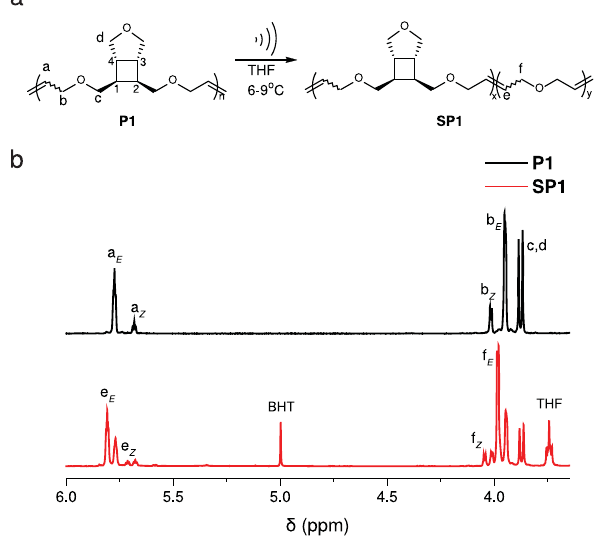
Fig. 4 | Mechanochemical activation of P1 . a P1 is subjected to ultrasonication, resulting in SP1 , which is a copolymer of P1 and poly(2,5-diydrofuran). b Partial 1 H NMR of P1 before (black) and after (red) sonication for